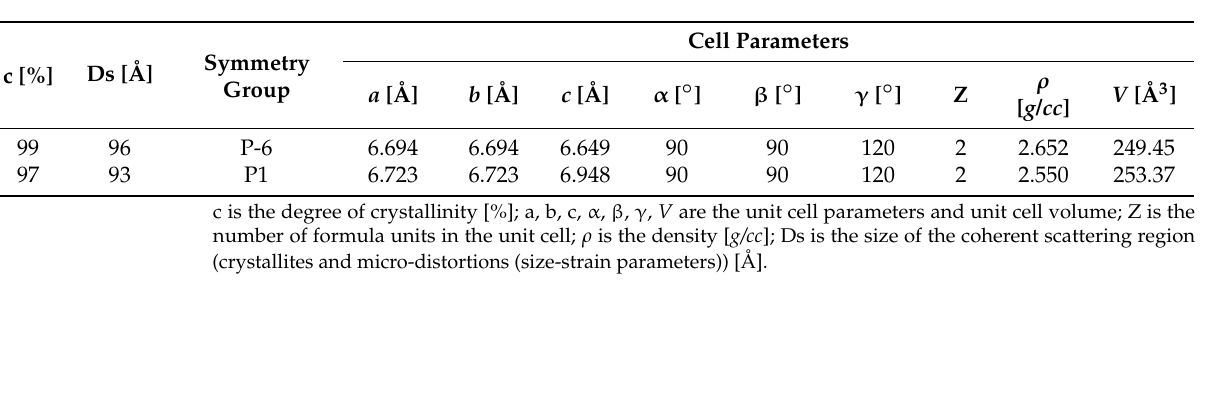
Table 7. Crystal structure of the obtained α -phase of carbon